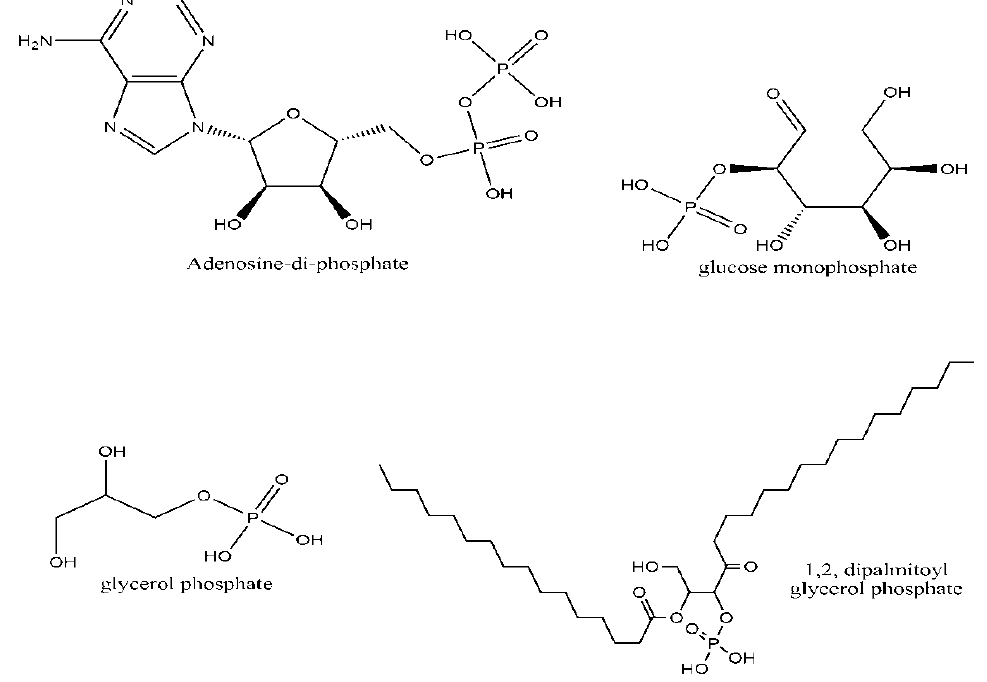
Figure 2. Some biological phosphates that are vital for cellular activities and hence for life. These include simple sugar phosphates such as glycerol phosphate (for respiration and cell structure) and highly complex molecules such as nucleotides (for storing information), and phospholipids (for